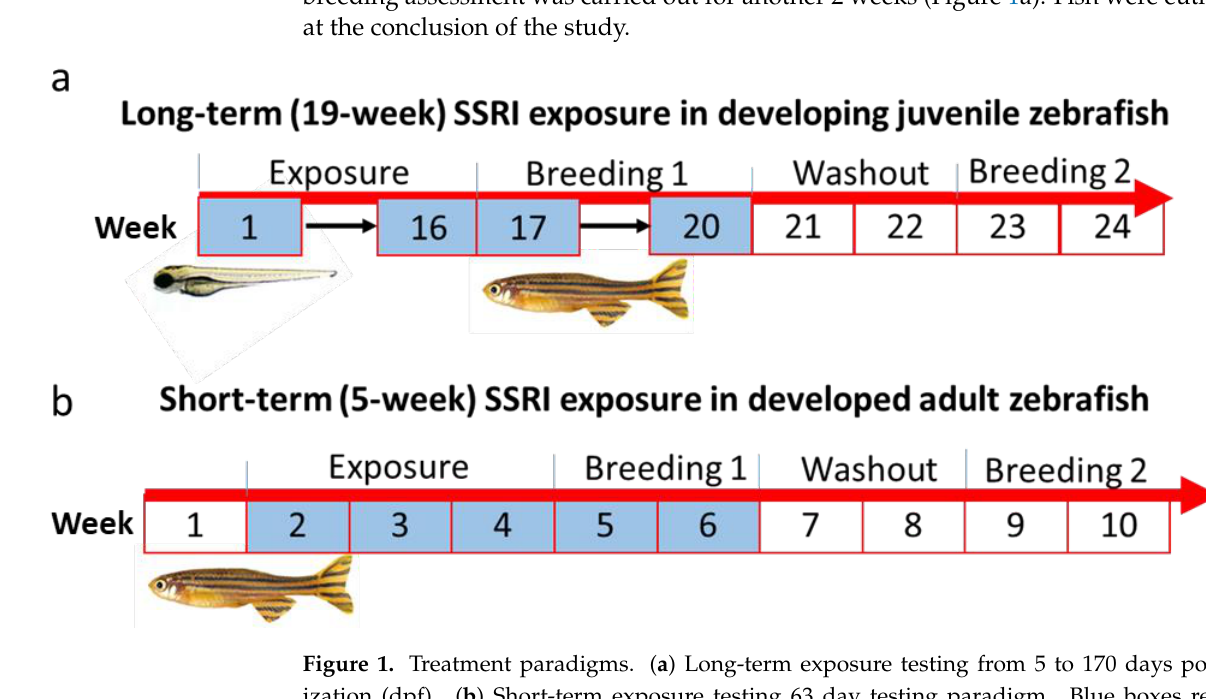
Figure 1. Treatment paradigms. ( a ) Long-term exposure testing from 5 to 170 days post fertilization (dpf). ( b ) Short-term exposure testing 63 day testing paradigm. Blue boxes represent treatment periods.